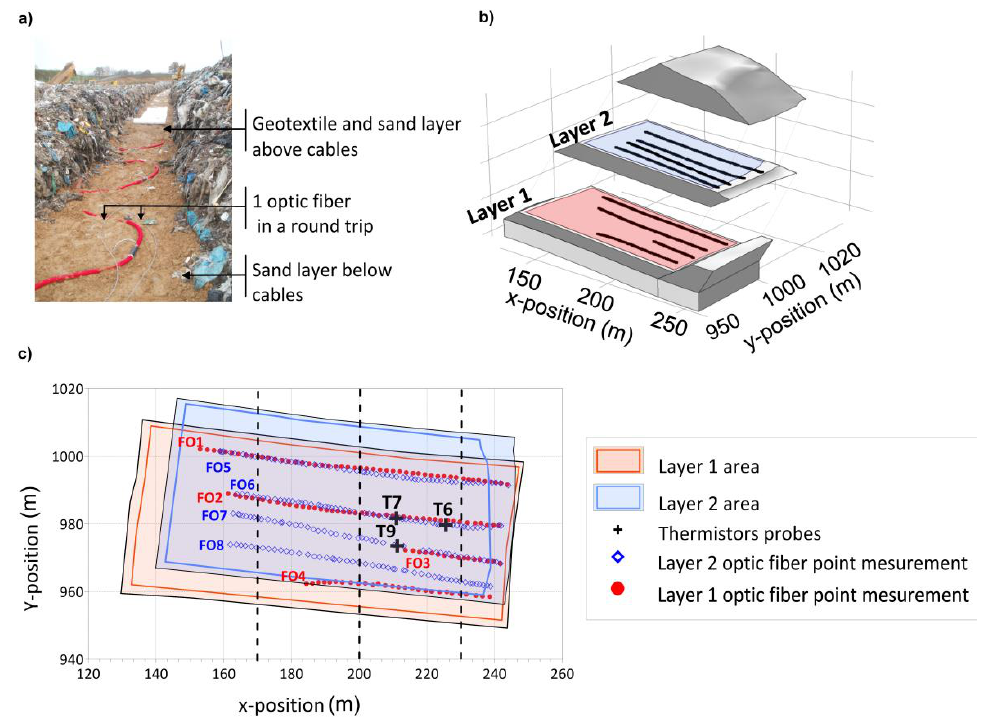
Figure 2. ( a ) Picture, ( b ) three-dimensional (3D) exploded view of experimental CELL4 and ( c ) Layer 1 and Layer 2 on CELL4 for the temperature distribution